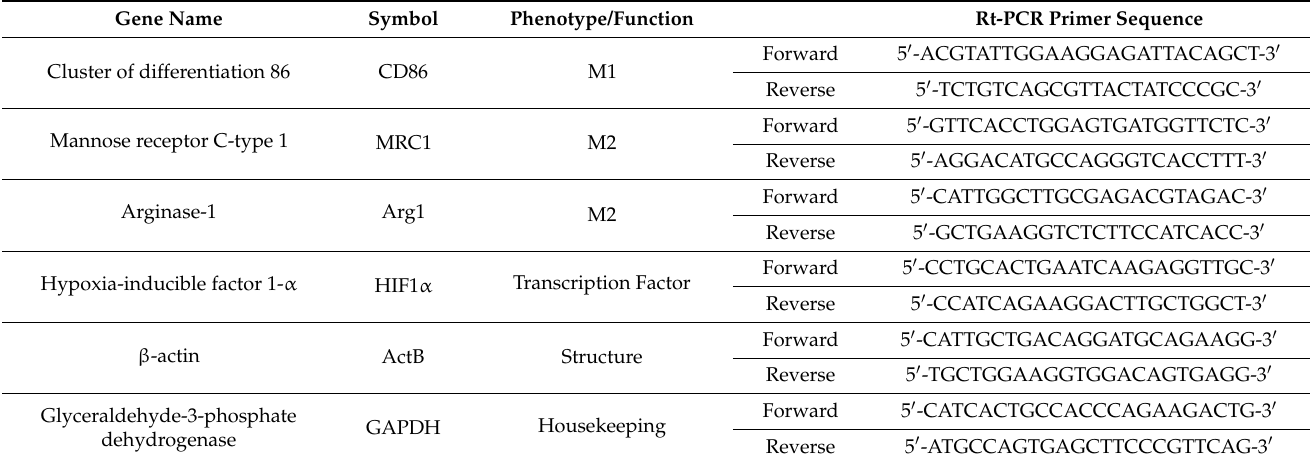
Table 1. Primer sequences for PCR